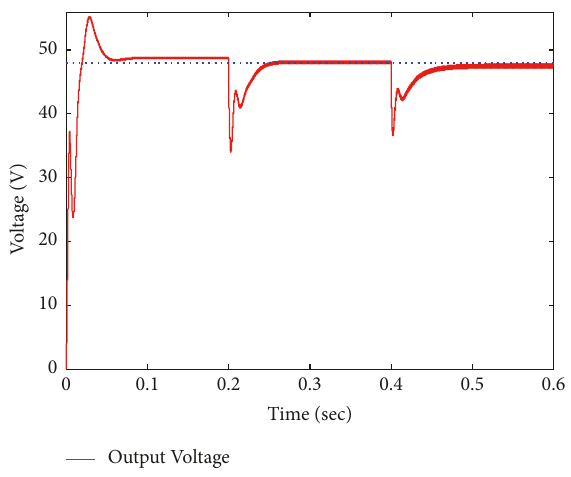
Figure 19: Output voltage with reference